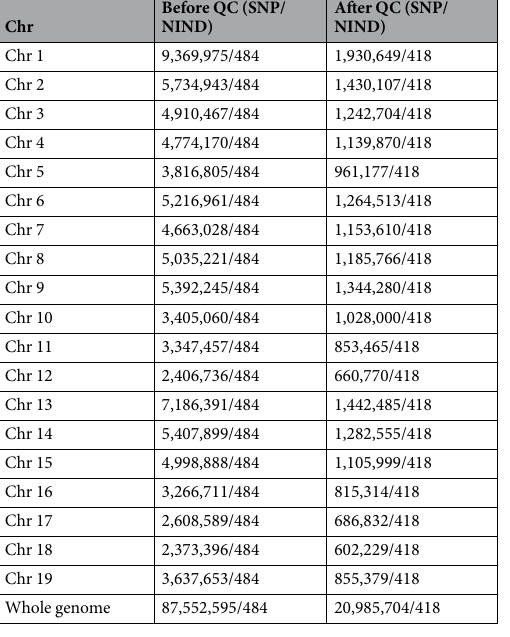
Table 2. The distribution of SNPs in different chromosomes. Chr : chromosome number; QC : quality control. the QC condition was MAF > 0.01 and 66 individuals were removed for the case of without